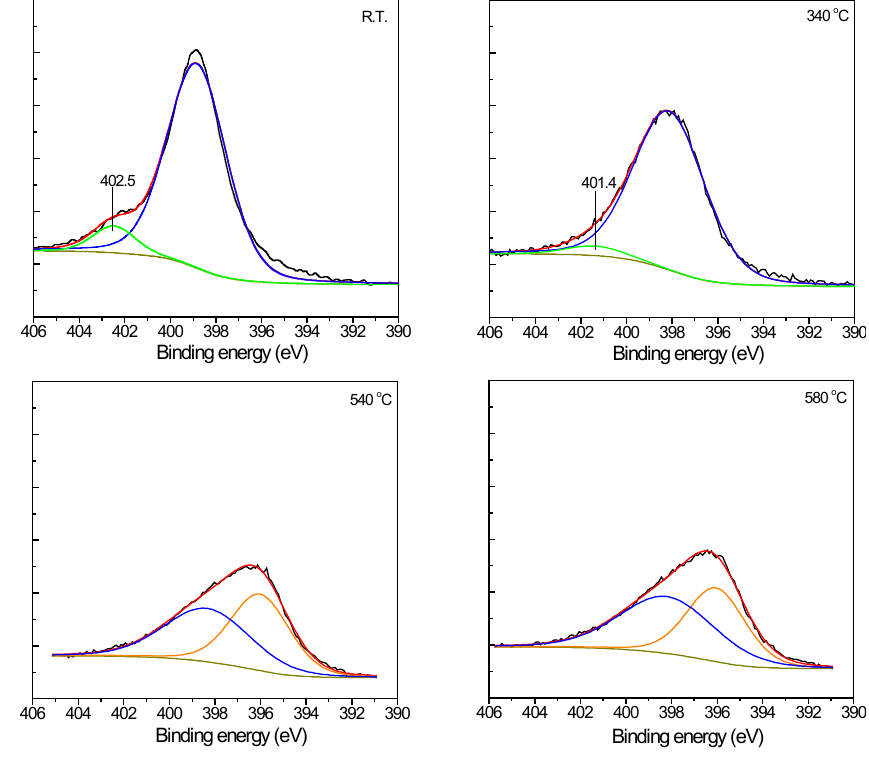
Figure 8. In situ XPS N1s for the APMV/CPM sample treated under